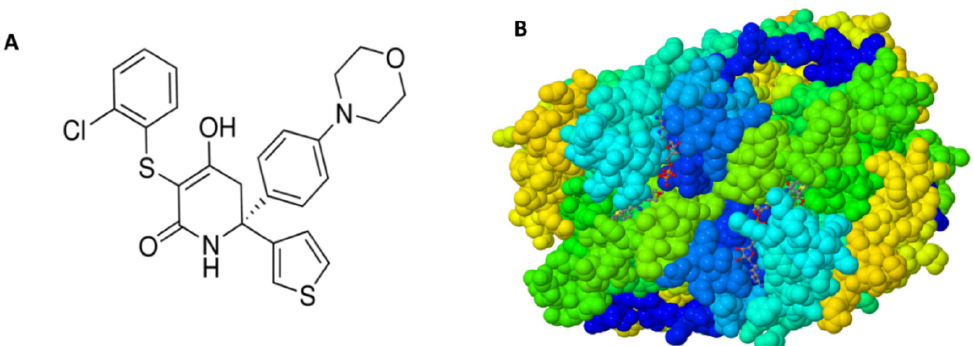
Figure 1. ( A ) Chemical Structure of GNE 140, a selective human lactate dehydrogenase (LDH) inhibitor (LDH-A, LDH-B, and LDH-C) and ( B ) Lactate dehydrogenase A in complex with a trisubstituted piperidine-2,4-dione-inhibitor GNE-140 (RCSB PBD). Source: https://www.rcsb.org/structure/